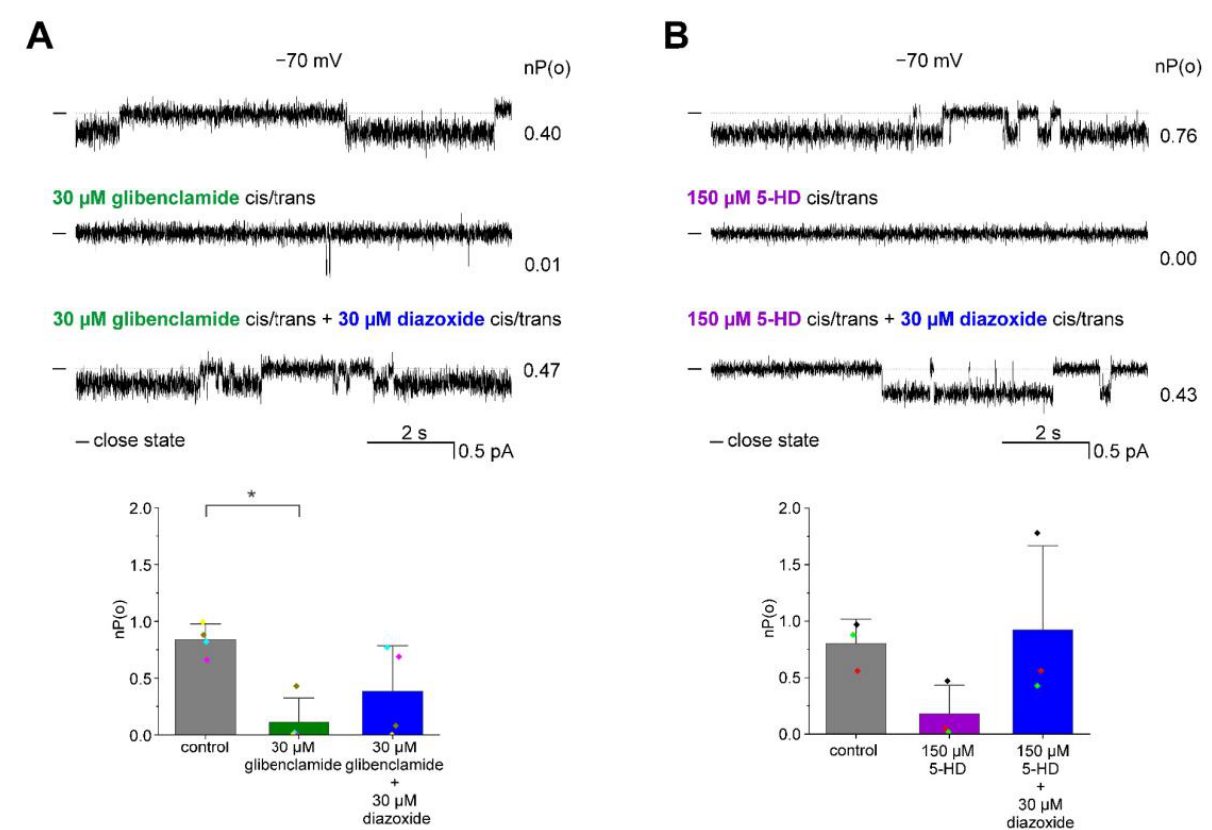
Figure 6. Inhibition of ROMK2 channel activity by glibenclamide and 5-HD. ( A ) Glibenclamide inhibits the activity of the ROMK2 channel. Top panel: Representative single-channel recordings at − 70 mV under control conditions, in the presence of 30 µ M glibenclamide followed by the addition of 30 µ M diazoxide. Lower panel: Channel open probability, nP(o), under control conditions, in the presence of 30 µ M glibenclamide and after the addition of 30 µ M diazoxide ( n = 4). ( B ) 5-HD blocks the activity of the ROMK2 channel. Top panel: Representative single channel recordings at − 70 mV under control conditions, in the presence of 150 µ M 5-HD and after the addition of 30 µ M diazoxide. Lower panel: Channel open probability, nP(o), in control conditions, in the presence of 150 µ M 5-HD, or 150 µ M 5-HD and 30 µ M diazoxide ( n = 3). “-” indicates a closed state of the channel. The results related to channel open probability are presented as means ± SD. * p < 0.05,.